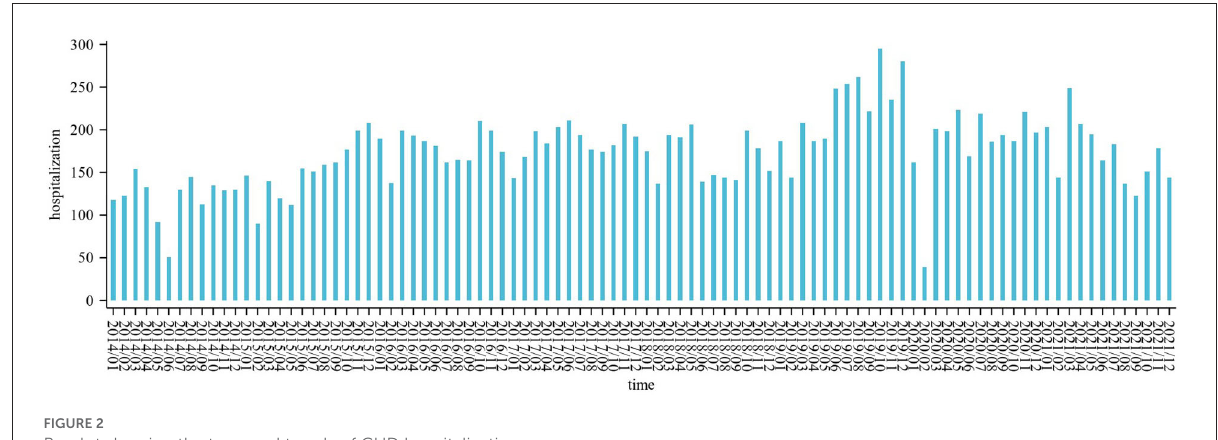
FIGURE2 Barplot showing the temporal trends of CHD